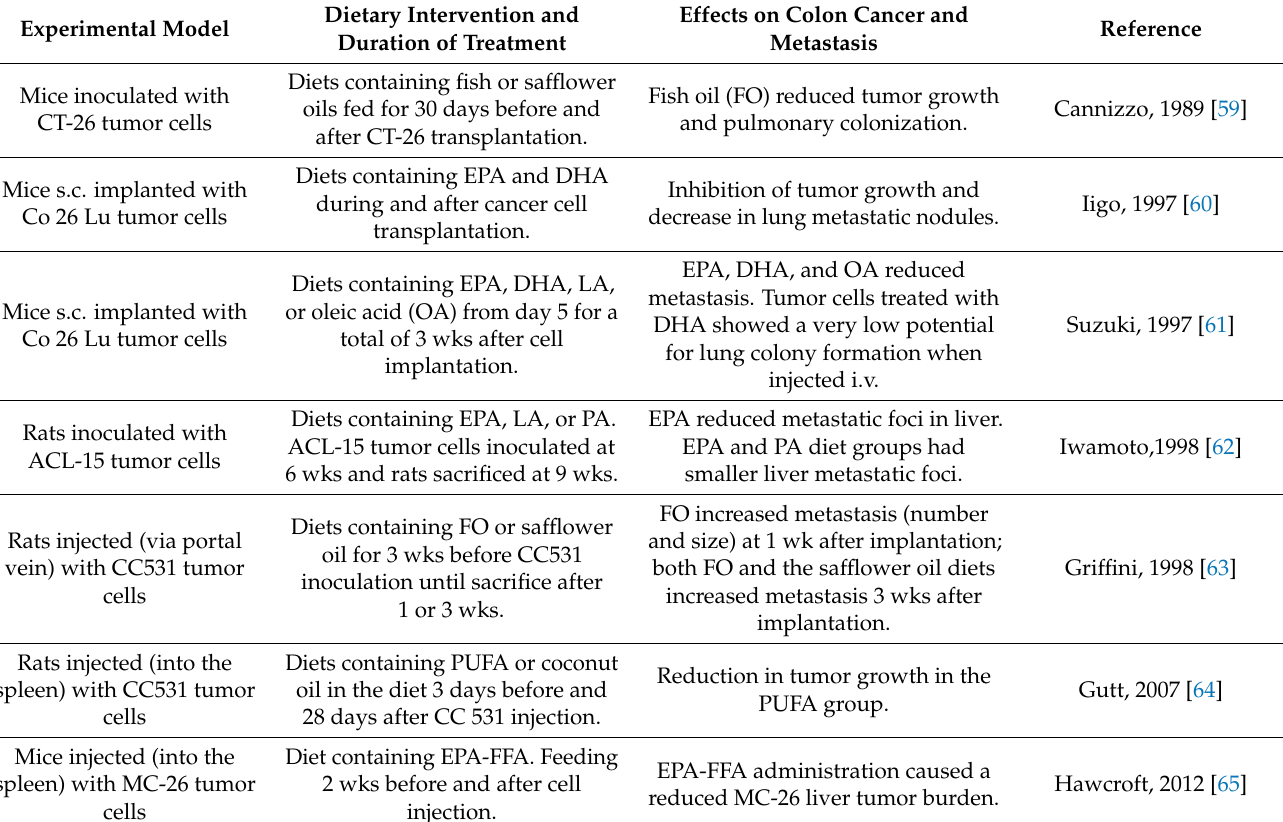
Table 5. Effects of fish or its components on different animal models of colorectal cancer metastasis. Experimental